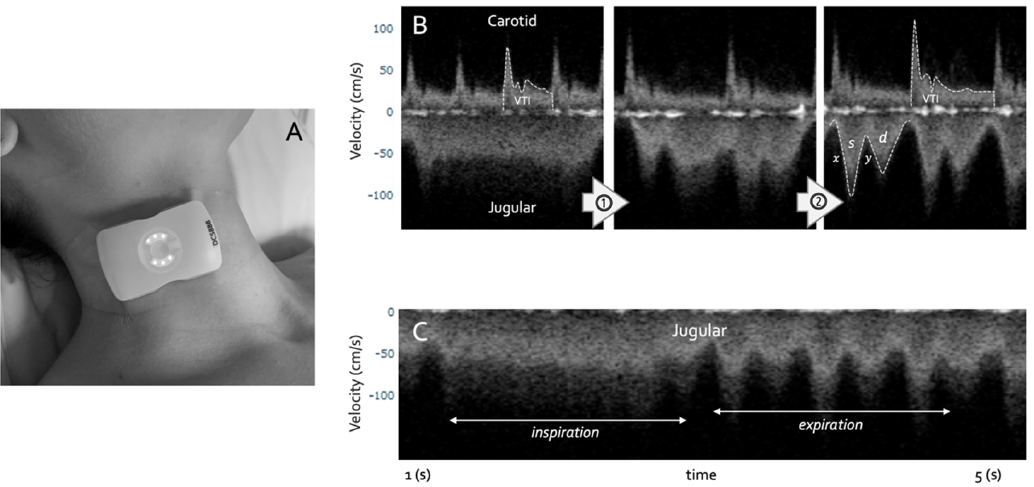
Figure 4. Simultaneous venous and arterial Doppler from a wearable ultrasound. ( A ) shows the wearable technology on a healthy volunteer. ( B ) shows the effect of rising preload from left to right (arrows 1 & 2 are ↑ preload). The jugular wave is amorphous indicating jugular collapse, as preload rises, the morphology of the jugular vein becomes more pulsatile and forms the s and d waves described above; the x and y refer to the pressure descents of the CVP. The carotid VTI also rises from left to right suggesting that the SV is rising with preload (e.g., quadrant 1 to 2, Figure 3). ( C ) shows just the jugular morphology from inspiration to expiration, intimating jugular collapse on inspiration.